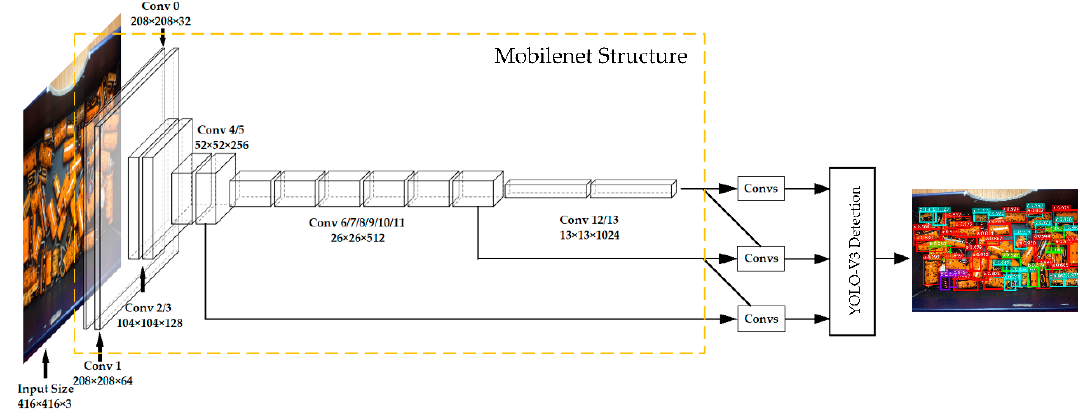
Figure 8. YOLOV3–Mobilenet detection network.